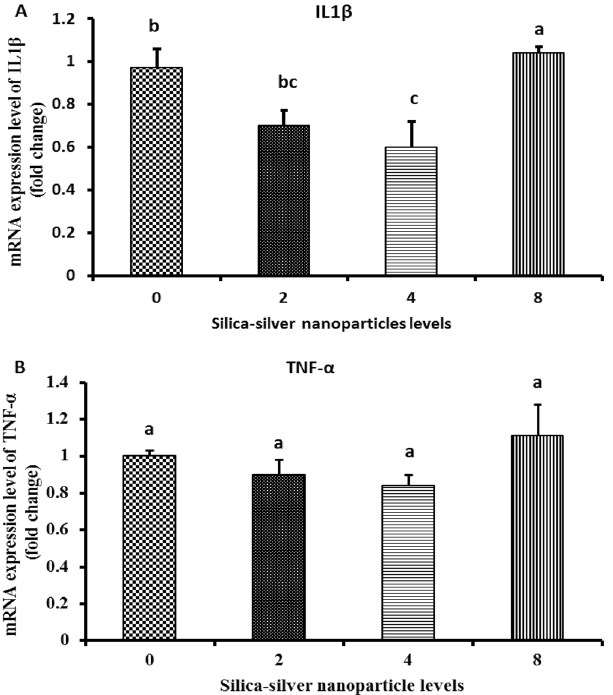
Figure 2. Effect of SiO 2 @AgNPs on mRNA expression of IL1β and TNF-α in muscle tissues. Groups having different letters are significantly different (P <